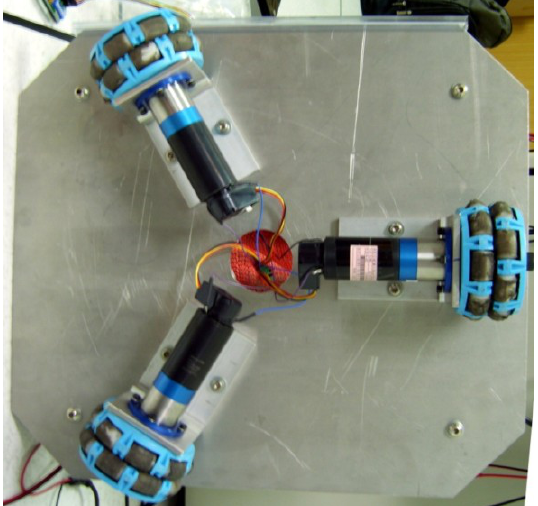
Figure 6. The experimental setup of the omni-directional mobile